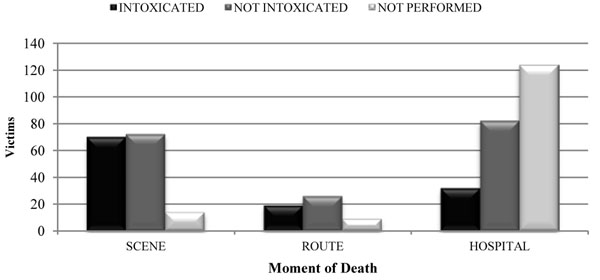
Relation of alcohol intoxication to moment of death.